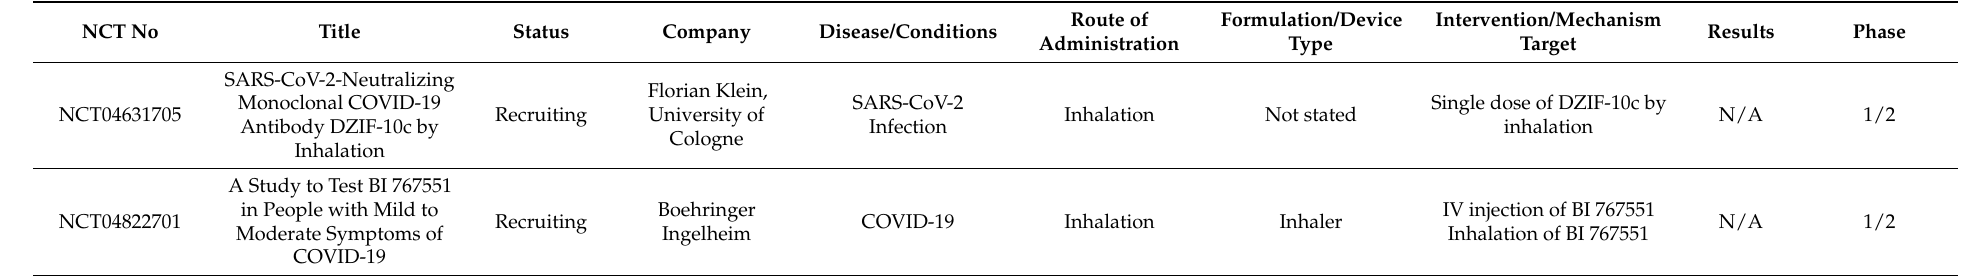
Table 2. Inhaled cellular immunotherapies clinical trials for respiratory